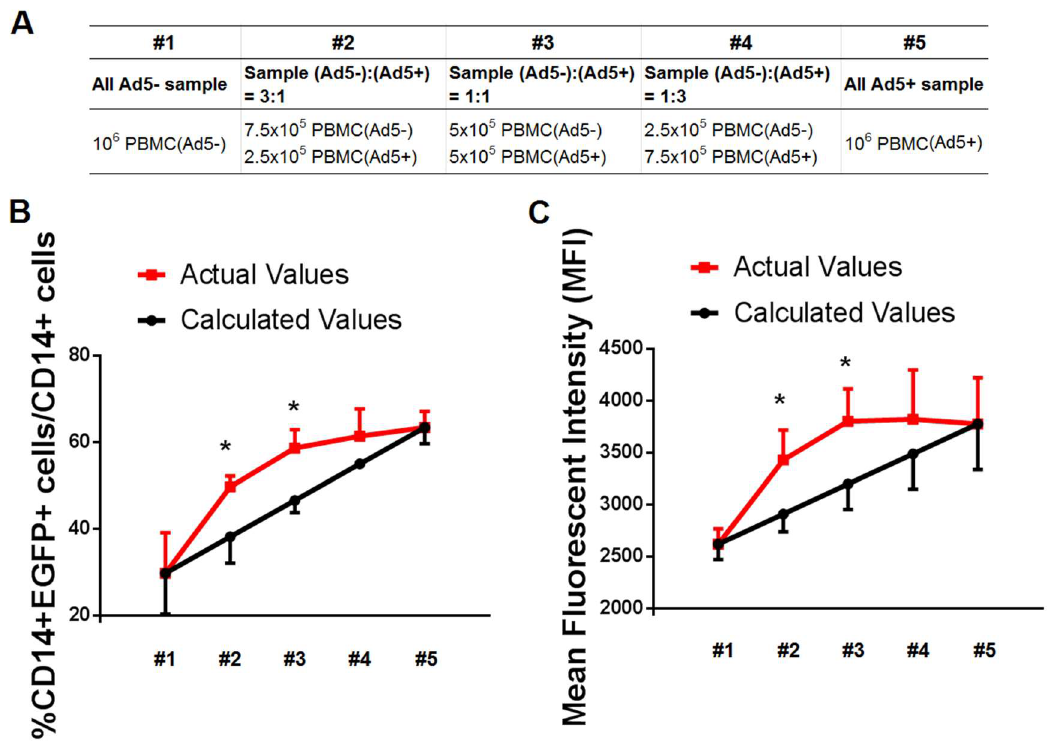
Figure 2. Secretory factors by PBMC samples of Ad-seropositive individuals contributed to promoting the efficacy of Ad infection. ( A ) Representative of paired PBMCs from Ad5-seronegative subjects and Ad5-seropositive subjects ( n = 3 pairs) mixed together at different ratios. ( B ) The actual and calculated percentage of EGFP-positive cells in CD14+ cells of PBMC mixture after infected with 1250 vp/cell Ad5-EGFP. ( C ) The actual and calculated expression level of EGFP protein (represented with MFI value) in CD14+ cells of PBMC mixture after infected with 1250 vp/cell Ad5-EGFP. These data were analyzed statistically by nonparametric Mann-Whitney U test. The bars represent the standard error. *: p < 0.05.